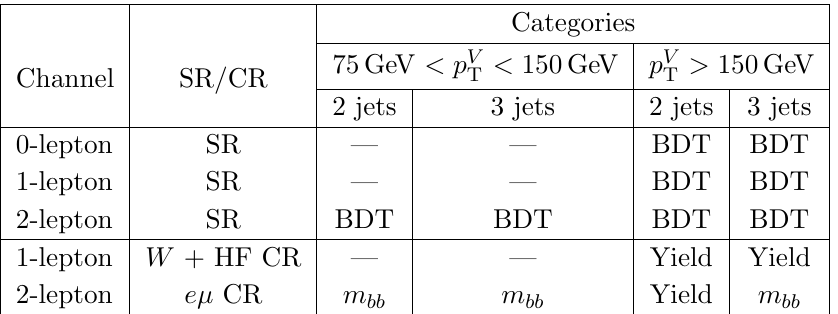
Table 9 . The distributions used in the global likelihood (cid:12)t for the signal regions (SR) and control regions (CR) for all the categories in each channel, for the nominal multivariate